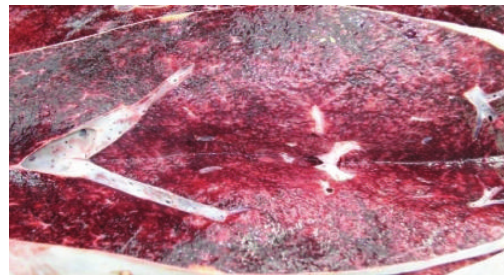
Figure 18: Postmortem appearance of the congested liver, indica- tive of chronic heart